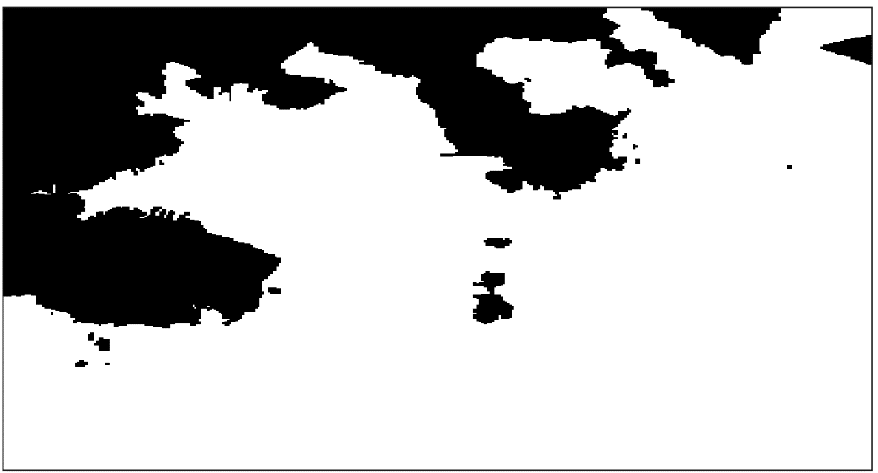
Figure 7. Region in binary image.